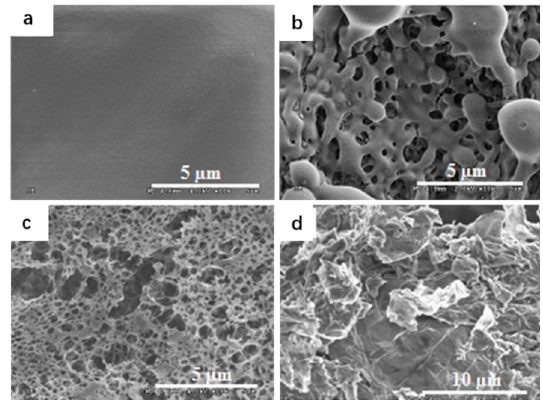
Figure 14. SEM images of pure and GO doped NC films. SEM image of ( a ) pure NC film, ( b ) 0.5% and ( c ) 2% GO doped NC film; ( d ) as-produced GO. Reprinted with permission from ref. [44]. Copyright 2013 AIP